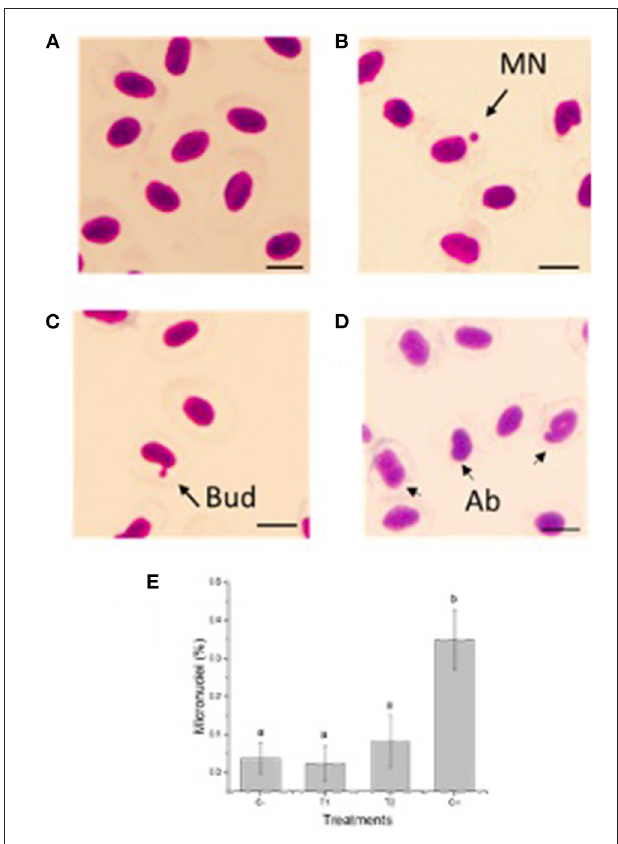
FIGURE 6 | Oreochromis niloticus erythrocytes stained with Giemsa observed under an Olympus Microscope, BX41, Japan, 1000 × . (A) Normal erythrocytes. (B) Micronucleus (MN). (C) Bud: Nuclear Bud. (D) . Ab: nuclear abnormalities. Bar: 20 µ m. (E) Micronuclei (%), same letters mean no significant differences (Tukey test: p < 0.05).